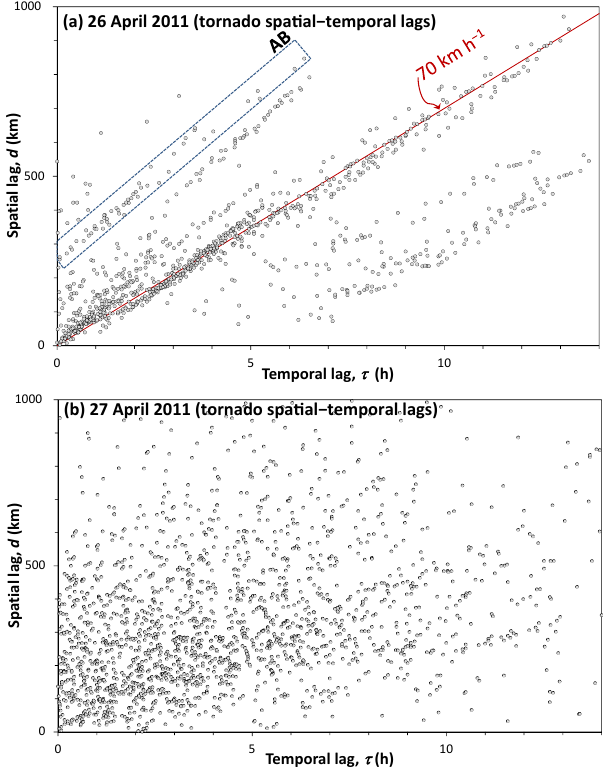
Figure 3. Tornado outbreak on 26–27 April 2011. Touchdown lo- cations of (a) 45 severe ( L ≥ 10km) tornadoes that occurred on 26 April 2011 (convective day, 06:00–06:00CST) and (b) 64 se- vere ( L ≥ 10km) tornadoes that occurred on 27 April 2011 (con- vective day). The touchdowns points for each tornado are given by colours and shapes (as given in the legend), representing successive 3h intervals. The tornado path lengths for each tornado are given by thin black lines. In (a) the tornadoes outlined in the regions A and B will be discussed in a later section. Data were obtained from NOAA (2015).